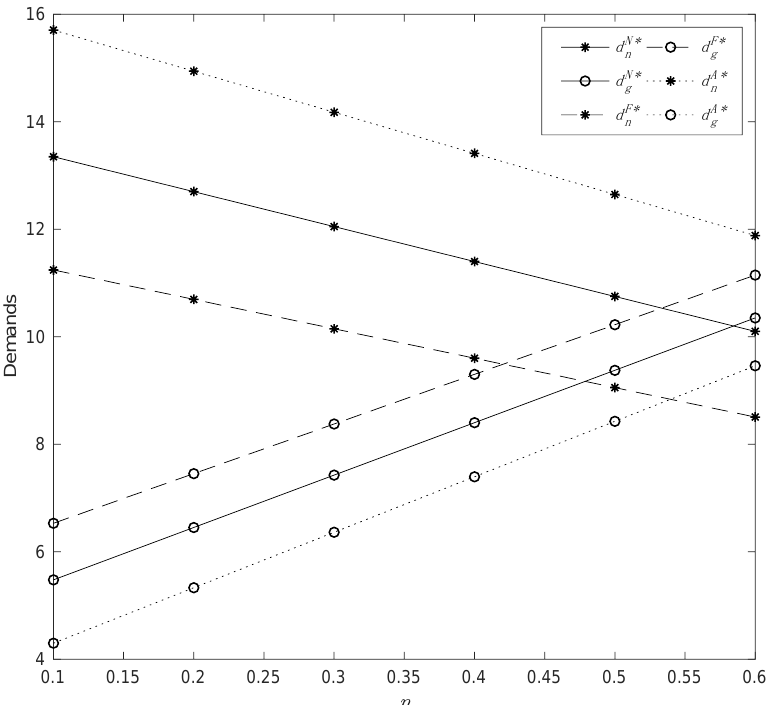
Figure 1. The change in demands with parameter η .